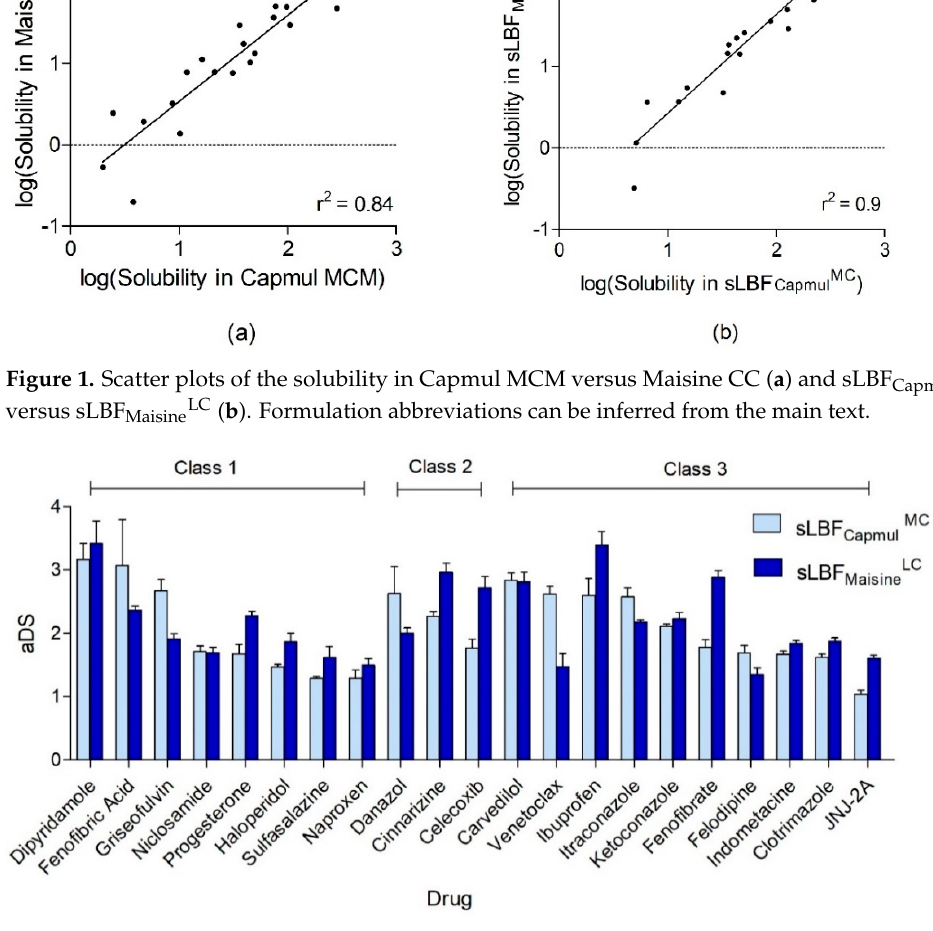
Figure 1. Scatter plots of the solubility in Capmul MCM versus Maisine CC ( a ) and sLBF CapmulMC versus sLBF MaisineLC ( b ). Formulation abbreviations can be inferred from the main text.